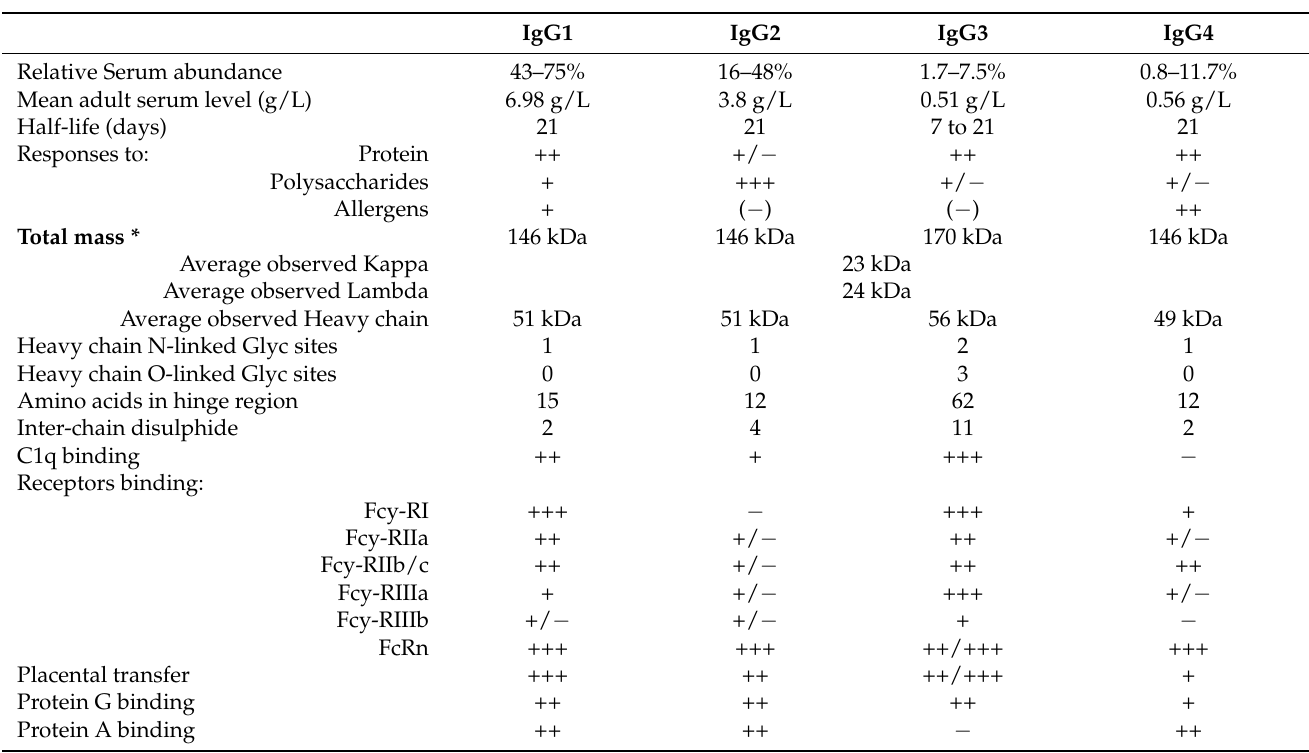
Table 1. Descriptive comparison of physical structure and functional biological differences between the four human IgG